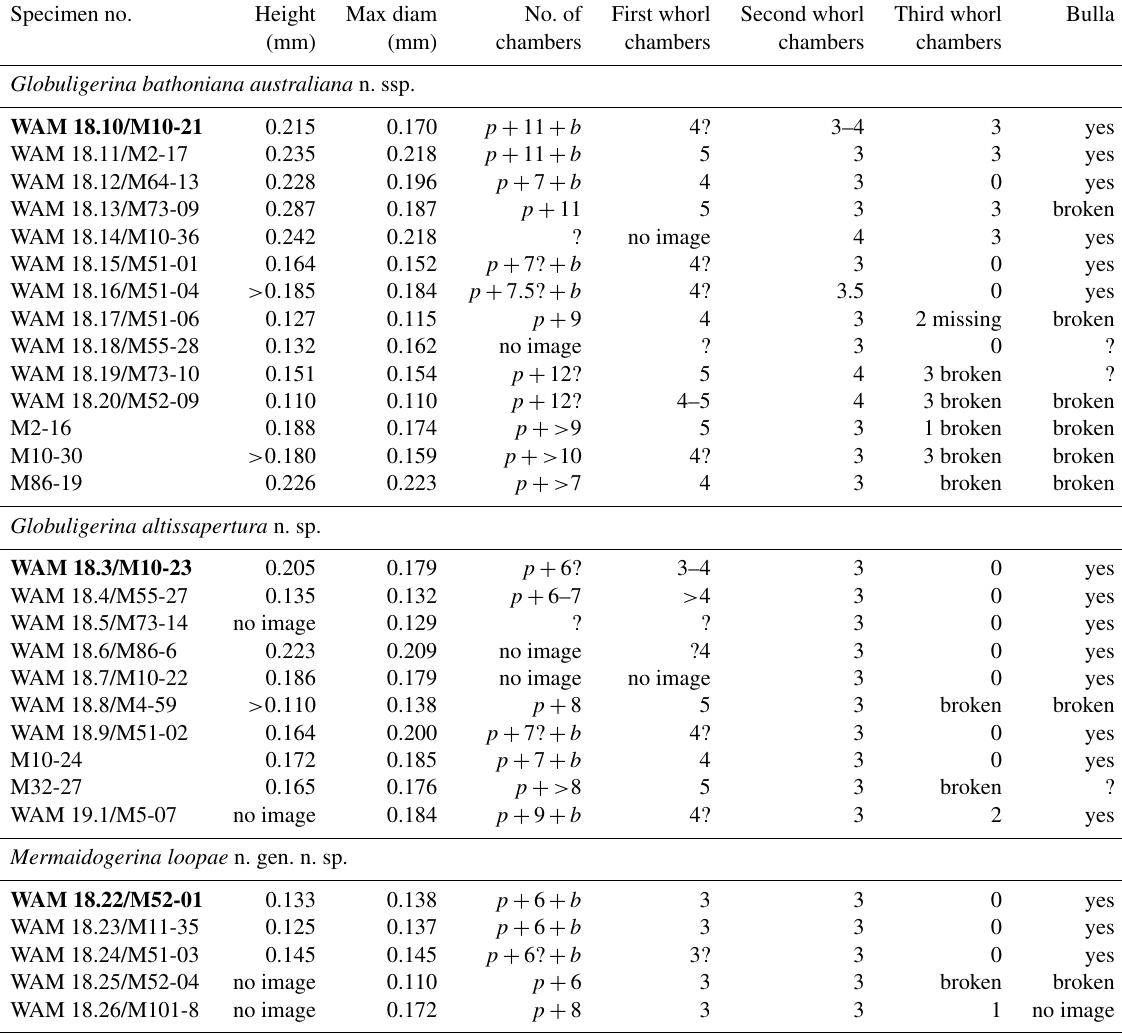
Table 1. Dimensions and number of chambers in each whorl of selected imaged specimens. Specimen numbers preceded by WAM are figured in this paper and lodged with the Western Australian Museum; /M indicates the same specimen with the imaging reference number. Specimens preceded only by M image numbers are shown in the Supplement. Specimens in bold type are the holotypes. p : proloculus; b : bulla; where “no image” is noted, no image at the appropriate orientation for dimensions is available. Specimen